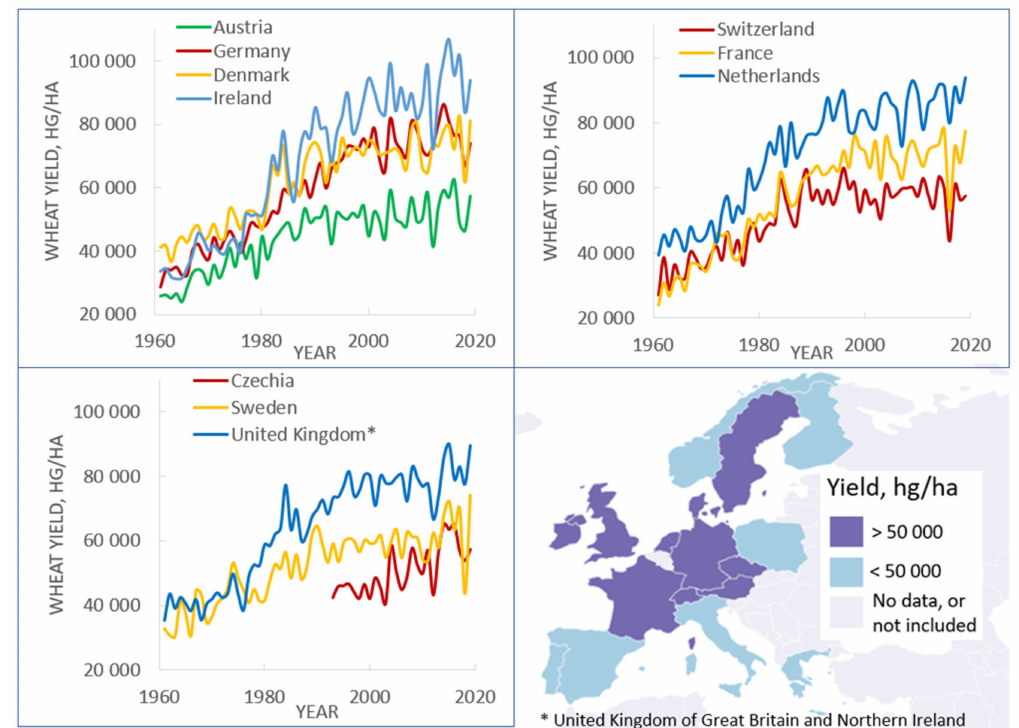
Figure 1. Wheat yield in 1961–2019 in European countries with a current yield of over 50,000 hg/ha. Countries are divided into three panels to avoid overlapping graphs. (Source: FAOSTAT, online database, http://www.fao.org/faostat/en/#data/QCL, accessed on 19 September 2021. Map was drawn at http://mapinseconds.com, accessed on 20 September